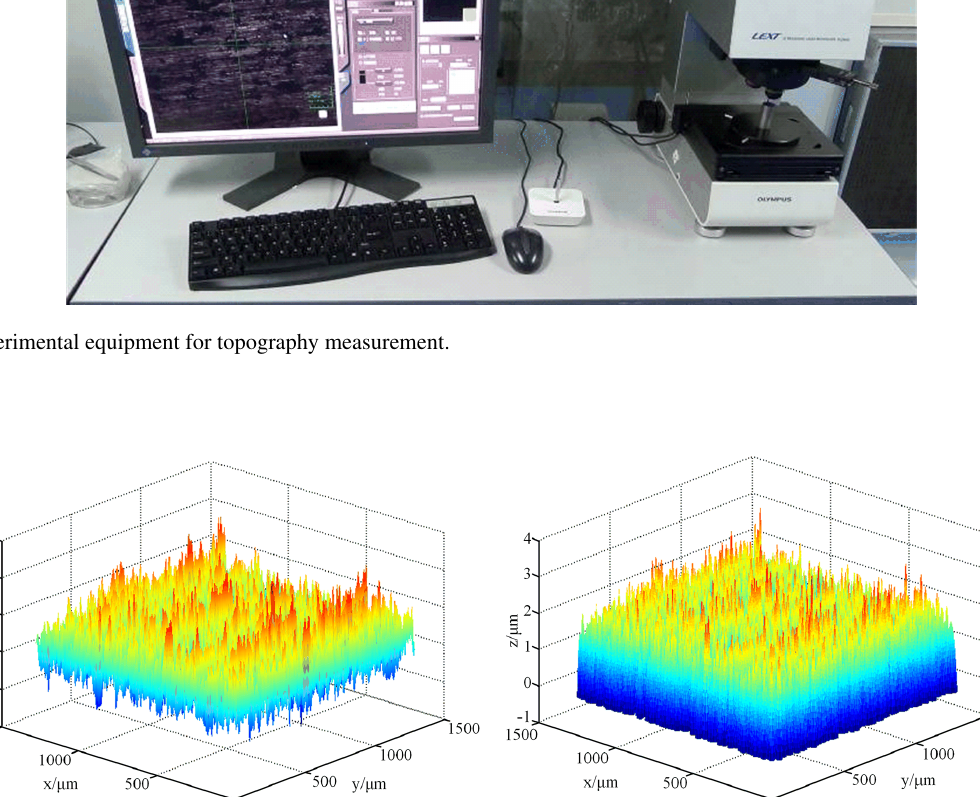
Mech. Sci., 12, 41–50, 2021